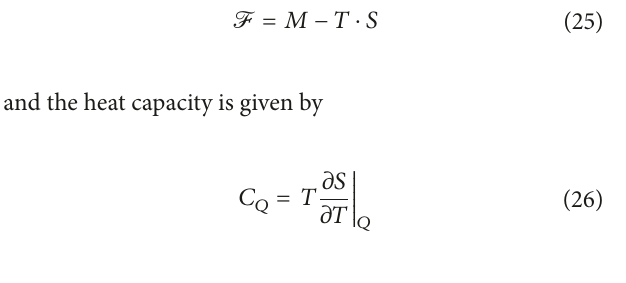
hole mass 𝑀 as an enthalpy [8] in the extended phase space context, the free energy F of black hole can be written